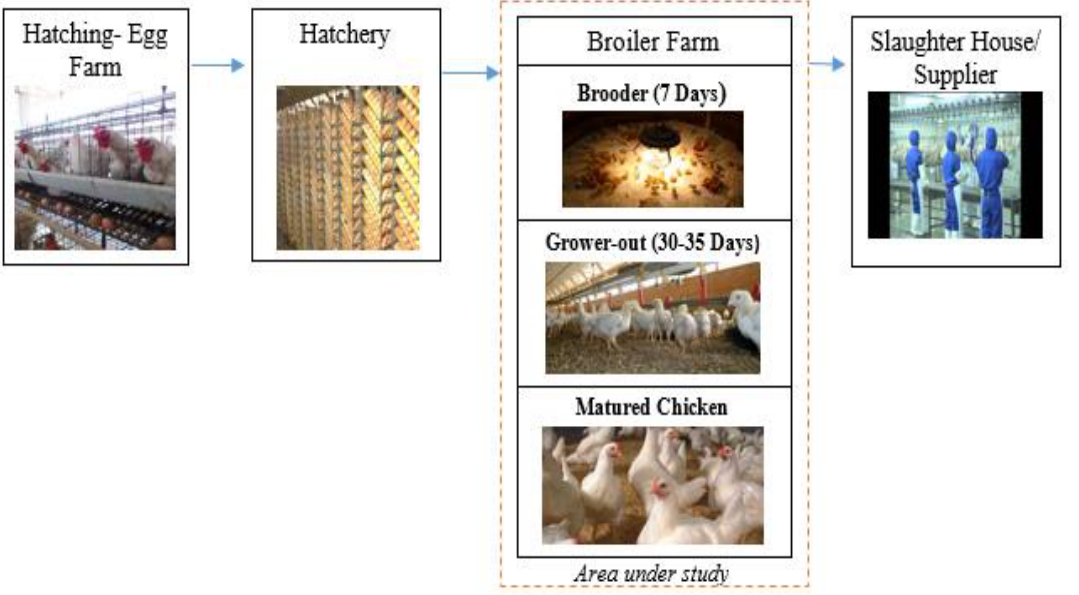
Figure 4: Process flow diagram of modern chicken farming supply chain in Malaysia